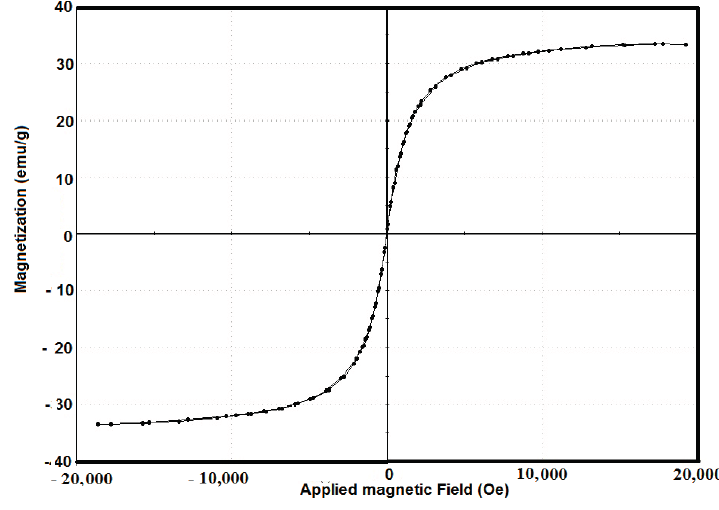
Figure 5. Hysteresis loop of the AA-Na/magnetite composite